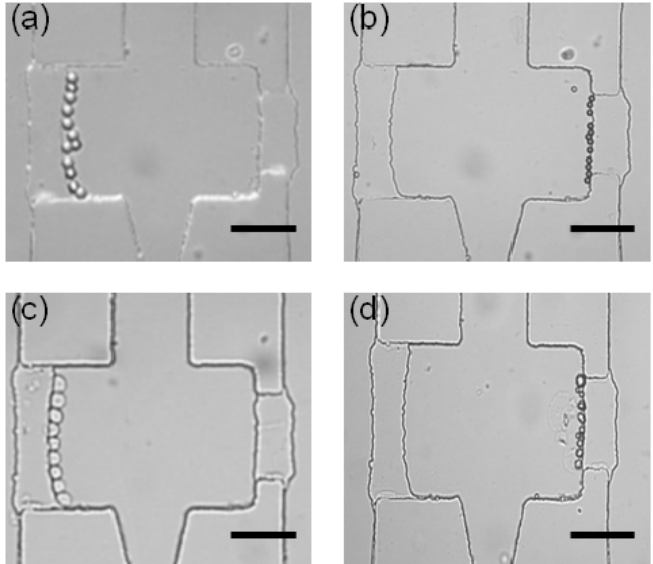
Figure 4. The photographs of particles in diameter of ( a ) 20 µm, and ( b ) 10 µm docked at the left and right sides, respectively. ( c ) The picture showed the cell docking of live K562 cancer cells. ( d ) The picture displayed the cell docking of live natural killer cells. Scale bar: 100 μ